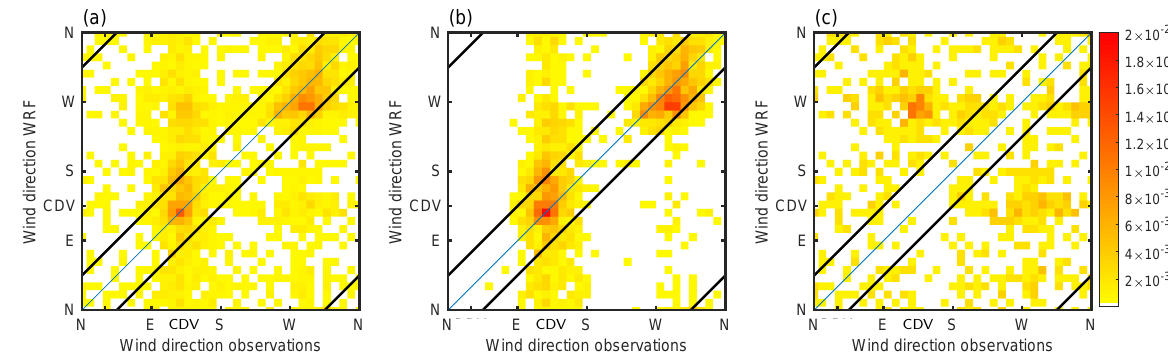
Figure 12. ( a ) Same as Figure 8a. ( b ) Same as subfigure ( a ), but only for “good” ANN forecasts based on the DACC. ( c ) Same as subfigure ( a ), but only for “bad” ANN forecasts based on the DACC. Black lines indicate 45° difference between WRF and